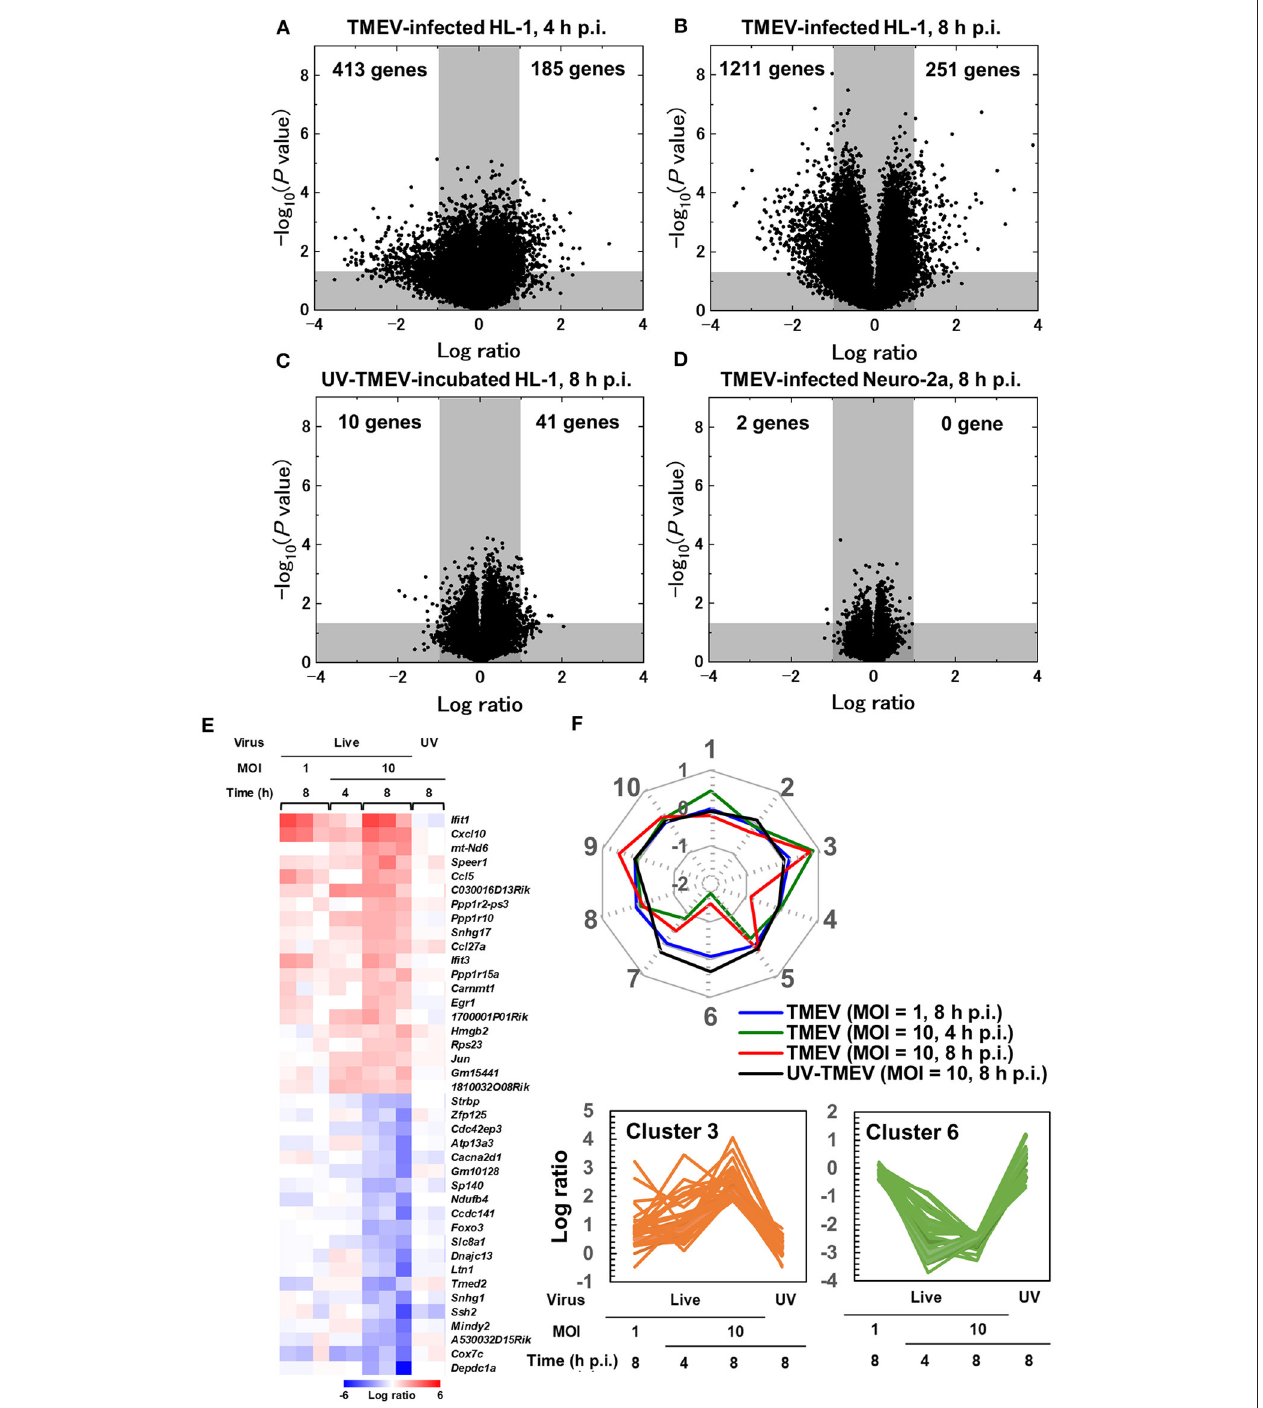
FIGURE 3 | Supervised bioinformatics analysis of transcriptome data from cardiomyocyte HL-1 cells infected with TMEV (33, 42). (A–D) Volcano plots of significantly up-regulated (upper right) or down-regulated genes (upper left) in TMEV-infected cells by the OriginPro 8.1 (OriginLab Corporation, Northampton, MA), to assess significance together with log ratio of transcriptome data ( Supplementary Materials and Methods ) (33). Log ratios of gene expression in the TMEV-infected cell culture compared with mock-infected cell culture were used as the x-axis and the logarithms of P values to base 10 were used as the y-axis. (A) TMEV-infected HL-1 cells at MOI = 10 at 4h p.i. (B) TMEV-infected HL-1 cells at MOI = 10 at 8h p.i. (C) HL-1 cells incubated with ultraviolet (UV)-irradiated TMEV for 8h. (D) TMEV-infected Neuro-2a cells s at MOI = 10 at 8h p.i. (E) Heat map of 20 up- or down-regulated genes in TMEV-infected HL-1 cells at MOI = 10 at 8 h p.i. by